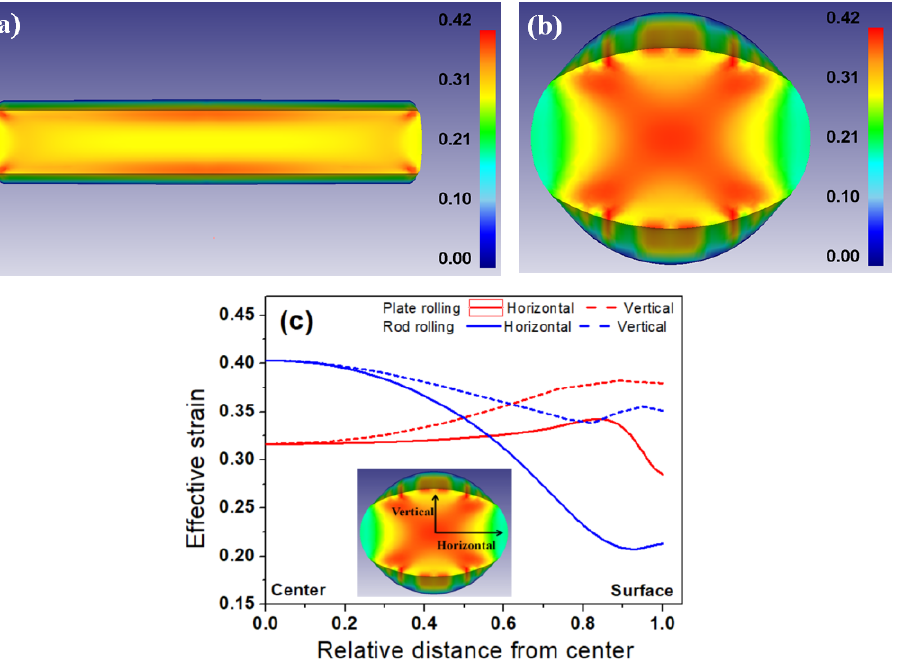
Figure 10. Contour maps of e ff ective strain of ( a ) plate, ( b ) rod, and ( c ) comparison of profiles of Figure 10. Contour maps of effective strain of ( a ) plate, ( b ) rod, and ( c ) comparison of profiles of e ff ective strain along the horizontal and vertical directions of a Figure 10. Contour maps of effective strain of ( a ) plate, ( b ) rod, and ( c ) comparison of profiles of effective strain along the horizontal and vertical directions of a workpiece. effective strain along the horizontal and vertical directions of a workpiece. Figure 10. Contour maps of effective strain of ( a ) plate, ( b ) rod, and ( c ) comparison of profiles of effective strain along the horizontal and vertical directions of a workpiece.